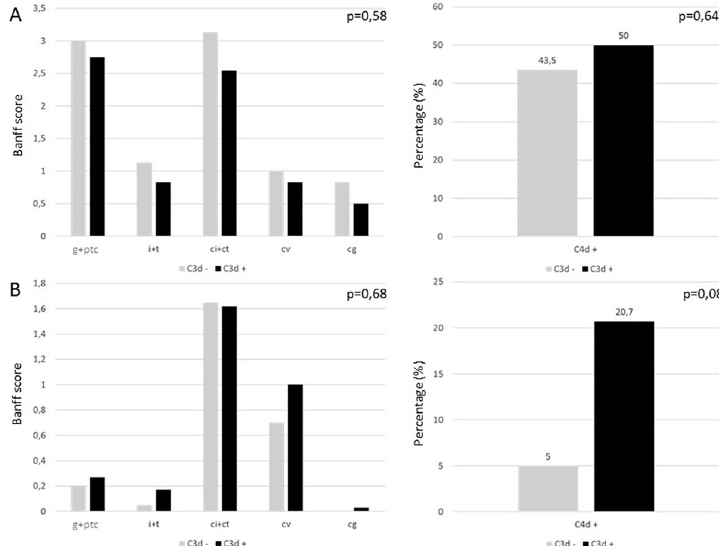
Fig 4. Banff lesions and peritubular capillary C4d staining according to C3d-fixing DSA status in (A) the 47 patients witch sABMR and in (B) 49 patients without sABMR. sABMR: subclinical ABMR; DSA: donor specific antibodies. For the Banff score: g: glomerulitis, i: interstitial inflammation, t: tubulitis, ptc: peritubular capillaritis, cg: allograft glomerulopathy, ci: interstitial fibrosis, ct: tubular atrophy, cv:fibrous intimal thickening. Each item is rated 0, 1, 2 or 3. For the C4d staining: each number on the top of the bar refers to the percentage of peritubular capillary C4d positive.